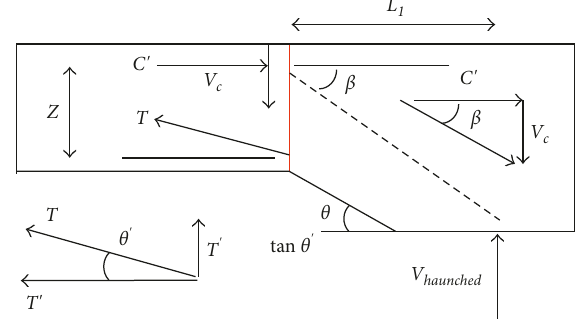
Figure 19: Forces in slabs with